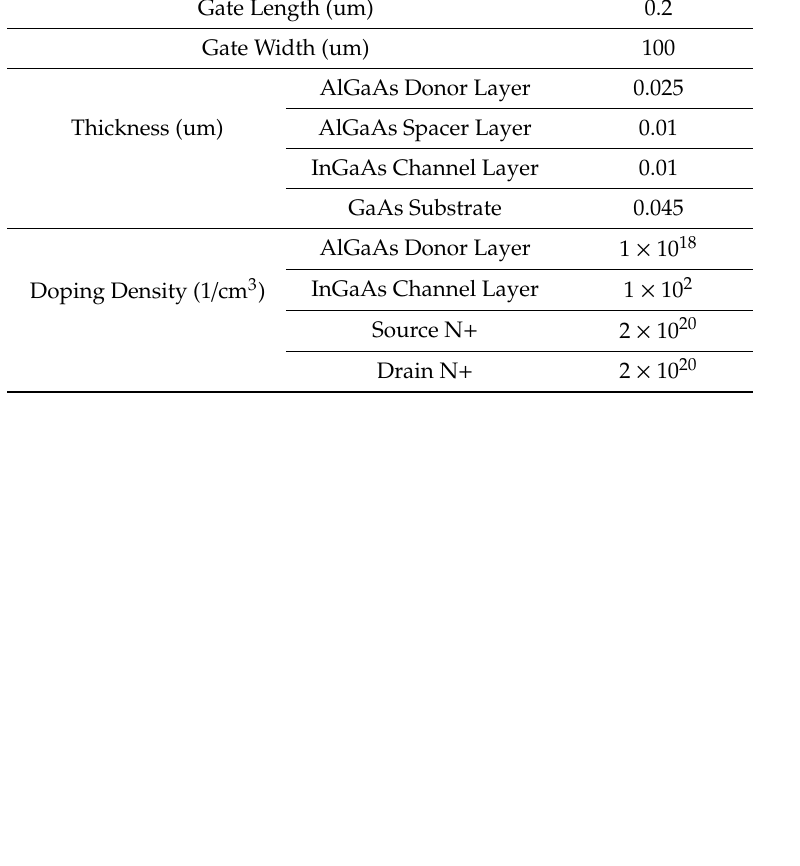
Figure 5. The structure of the high-electron mobility transistor (HEMT) device in Medici simulator used for data generation. Table 4. Values of geometrical / physical parameters for high-electron mobility transistor (HEMT) device. Parameter